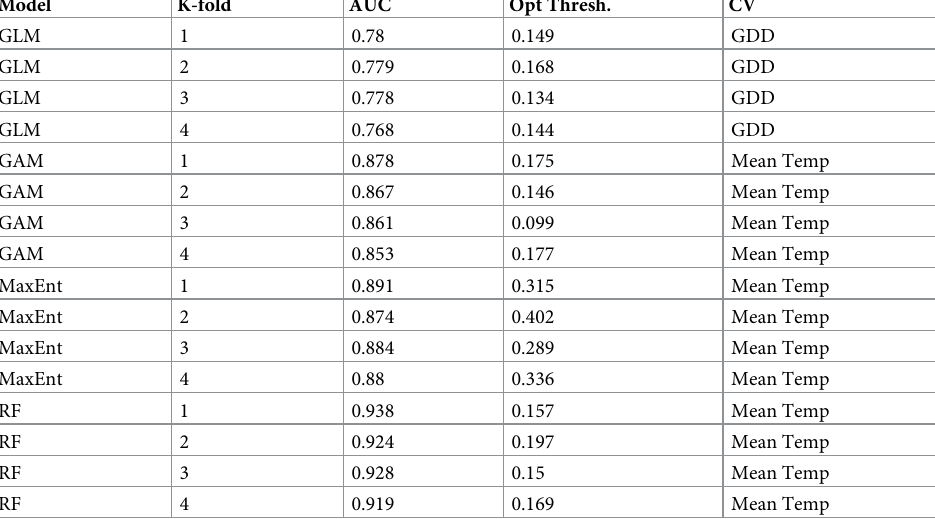
Table 2. The four-fold cross-validation results identify GLM as the least powerful and RF as the most powerful. All models produce an AUC, an optimal threshold (Opt Thresh.), and are capable of identifying the variable that con- tributes most to prediction (CV), but the machine learning methods often lack standard regression measures.